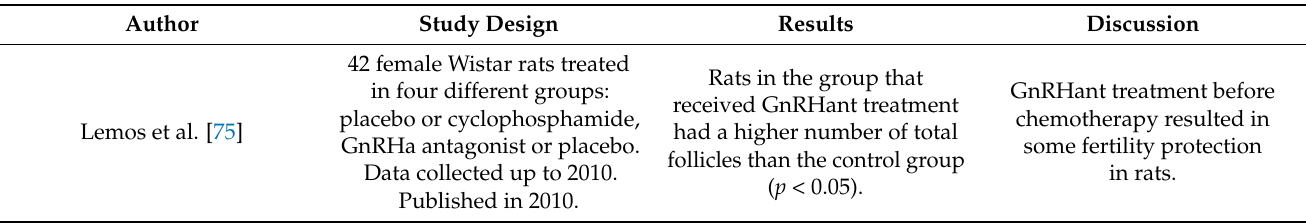
Table 3. GnRH antagonists only & fertility preservation during cancer